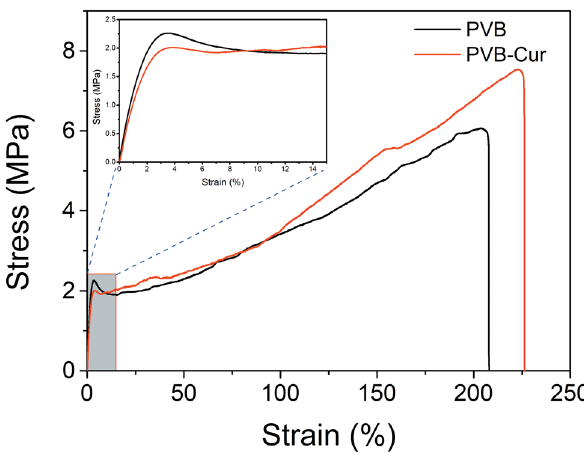
Figure 5: Strain – stress curves of PVB and PVB – Cur composite